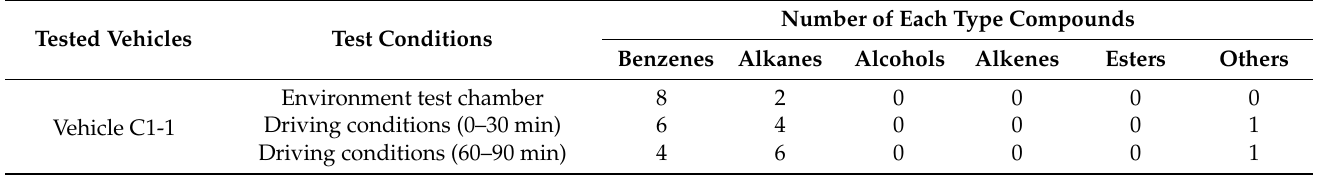
Table 5. Types of the top 10 VOCs identified in interior air samples of Brand